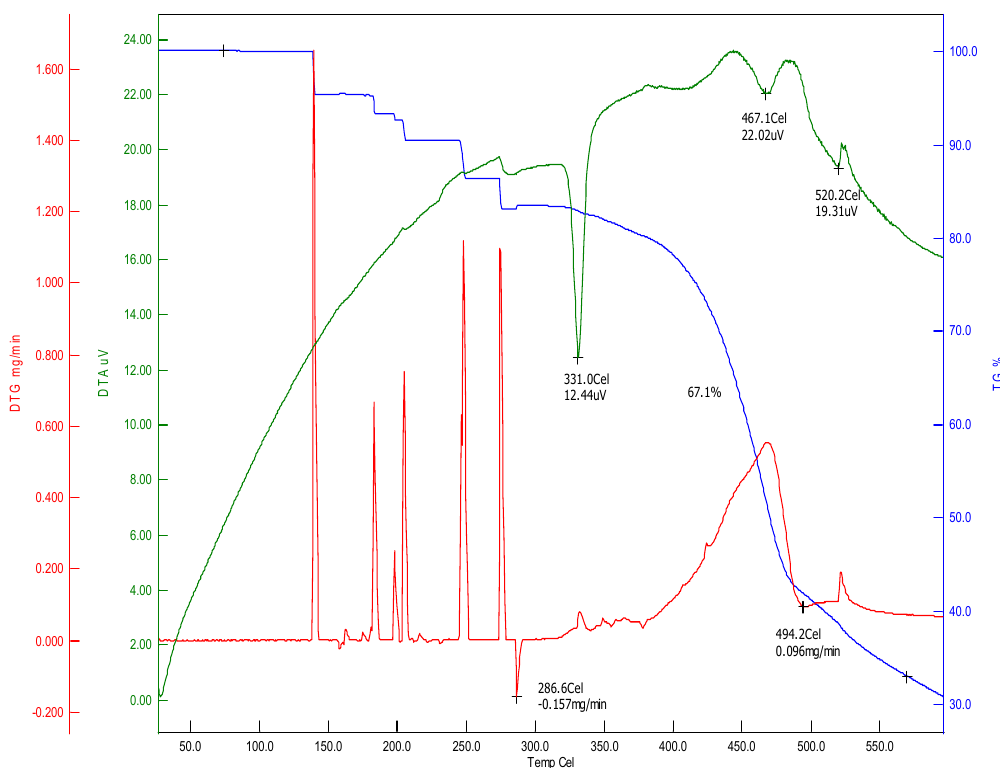
Fig. 6. Thermal behaviour of compound 1 nanoparticles prepared by sonochemical